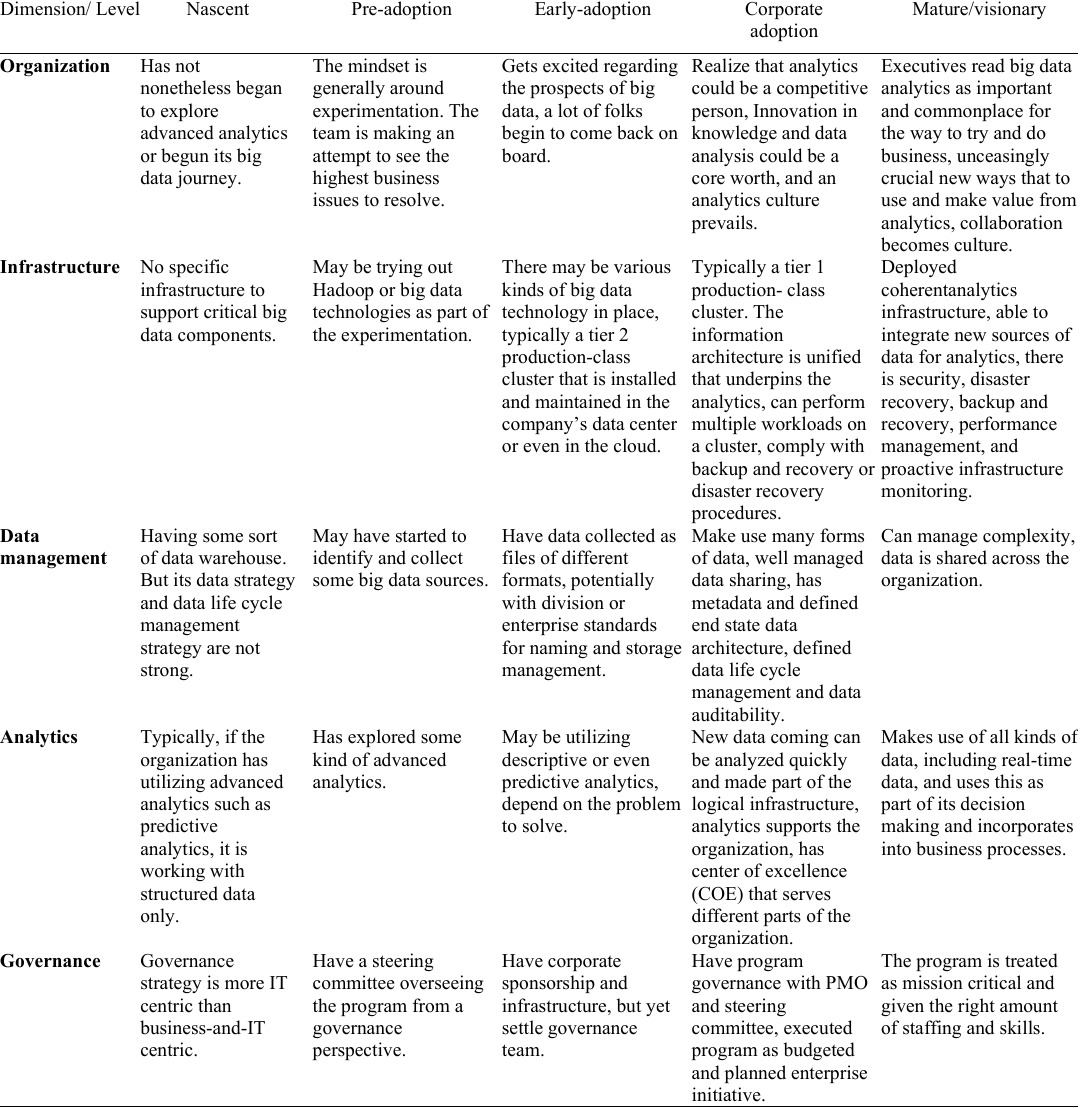
TABLE 1 A SUMMARY OF THE INDICATORS AT EACH TDWI BIG DATA MATURITY